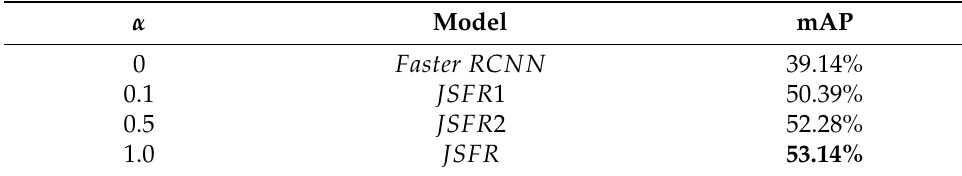
Table 4. The ablation experiments for hyperparameter α